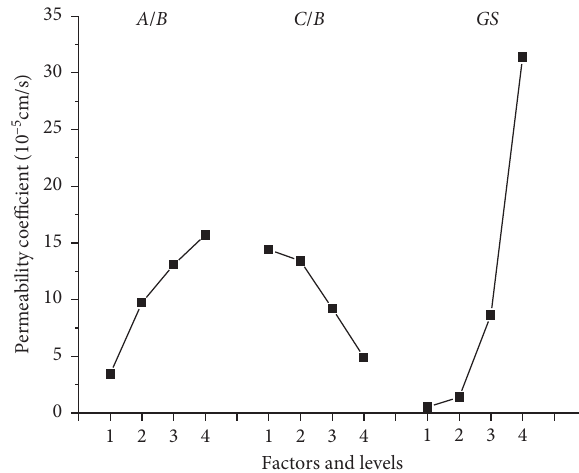
Figure 4: Sensitivity analysis of water absorption. Table 7: Extremum difference analysis of the softening coefficient. Factor